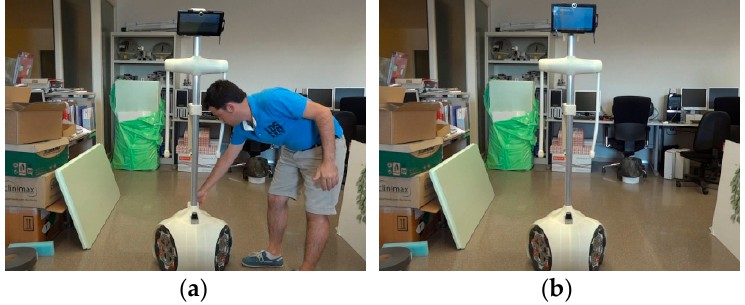
Figure 12. ( a ) Starting the APR; ( b ) APR initializing the onboard sensors and initializing the Tablet of the